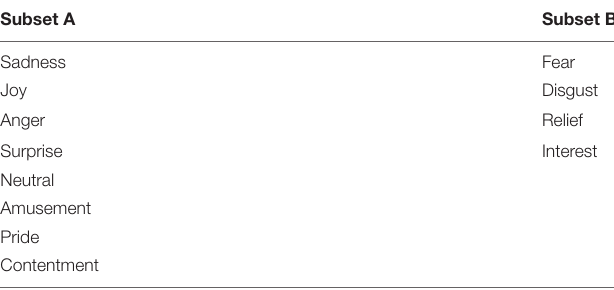
TABLE 4 | Emotion conditions in